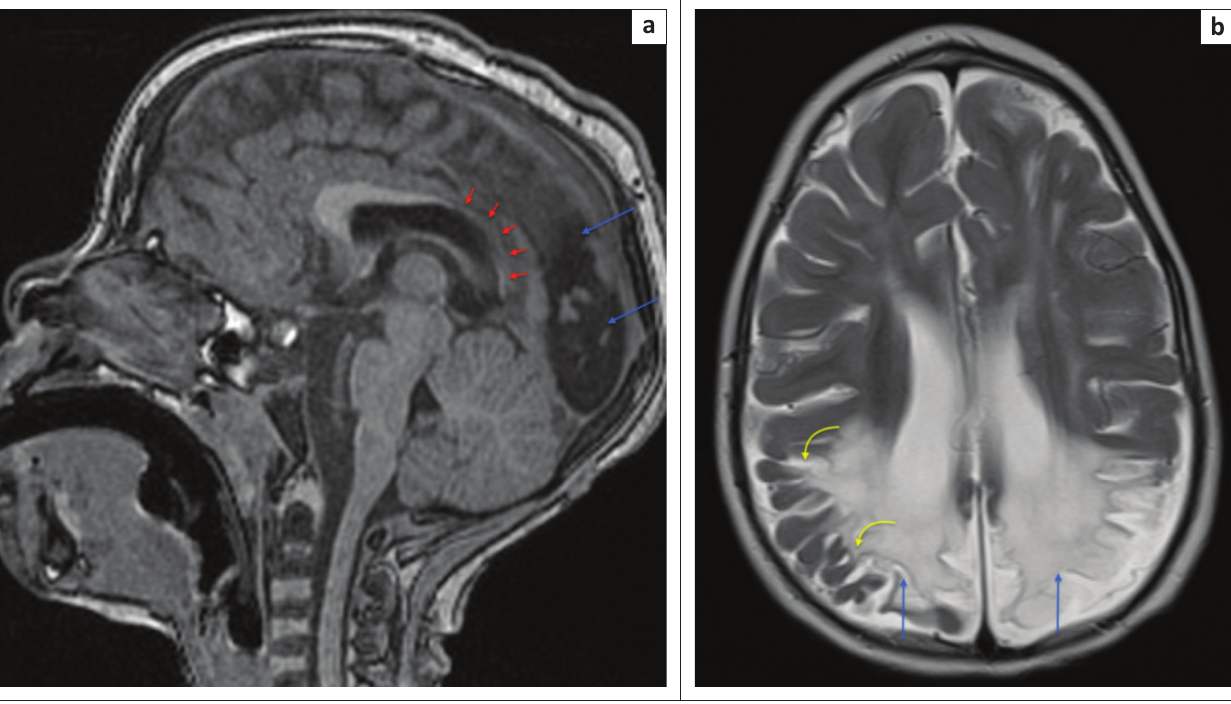
FIGURE 18: (a) Sagittal T1-weighted image at the midline of the calvarium demonstrating advanced spongiosis of the parietal and occipital lobes (blue arrows) associated with deafferentation thinning of the splenium and isthmus of the corpus callosum (red arrows). Note relatively normal calibre anterior body and genu of corpus callosum. (b) Axial T2-weighted image showing severe biparietal atrophy with ex vacuo dilatation of the lateral ventricles and evidence of ulegyria (yellow arrows). Note less marked changes in the frontal